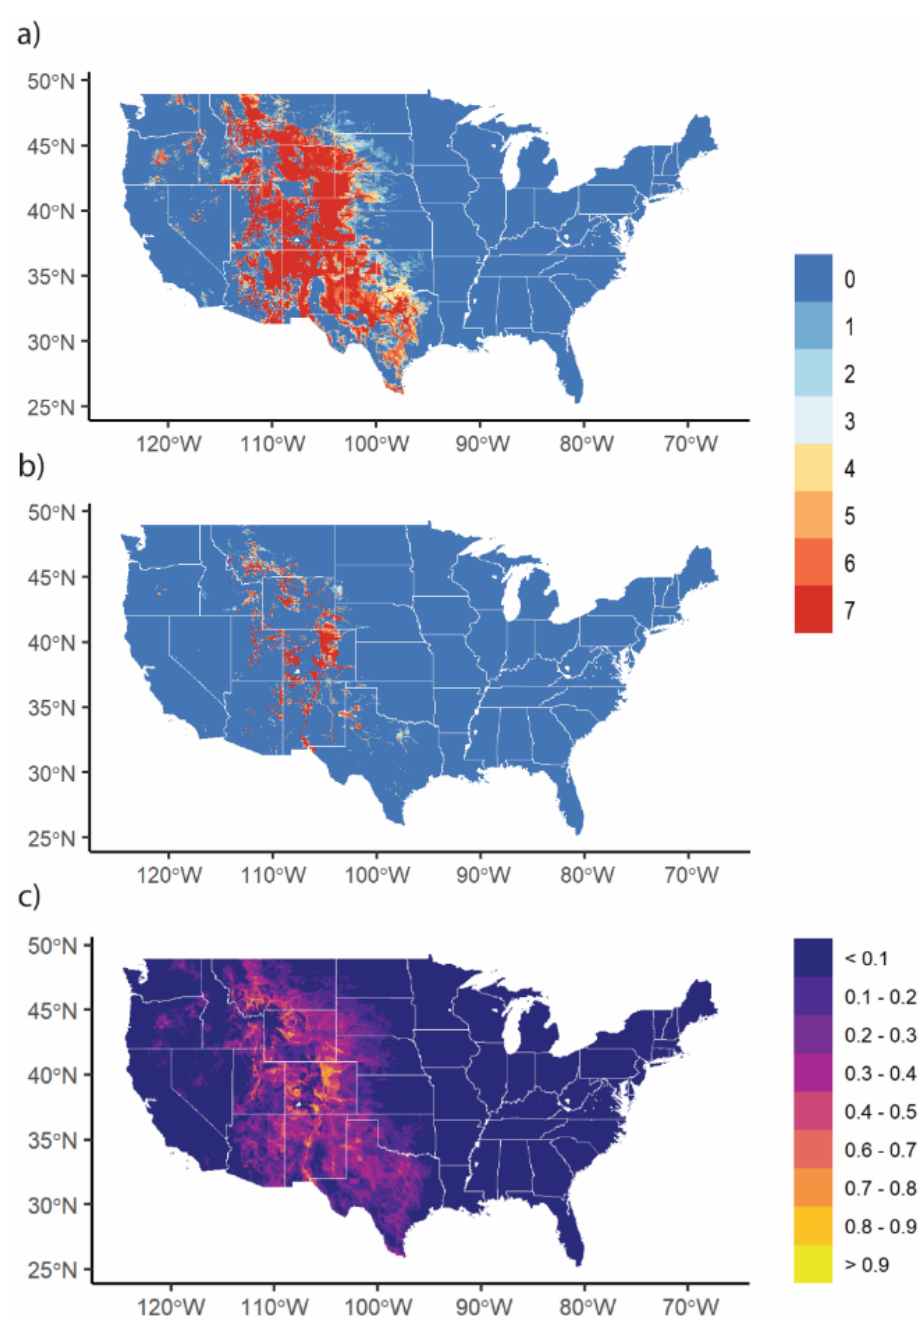
Figure 6. The agreement between GCMs shown as the number of models (out of 7 total) for RCP 4.5 projections that have ROR ( a ) greater than 0.2 and ( b ) greater than 0.5. The averaged MaxEnt estimated occurrence of all GCMs for projected climate scenario RCP 4.5 is shown in panel ( c ).